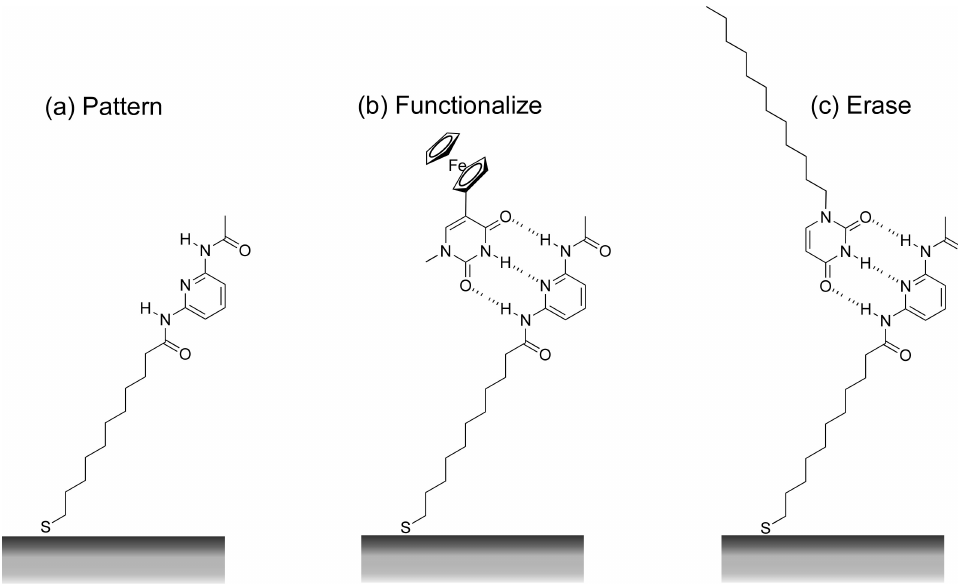
Figure 7. Functionalization and erasing at the surface of self-assembled monolayer. Reprinted with permission from [71] ©2002, American Chemical